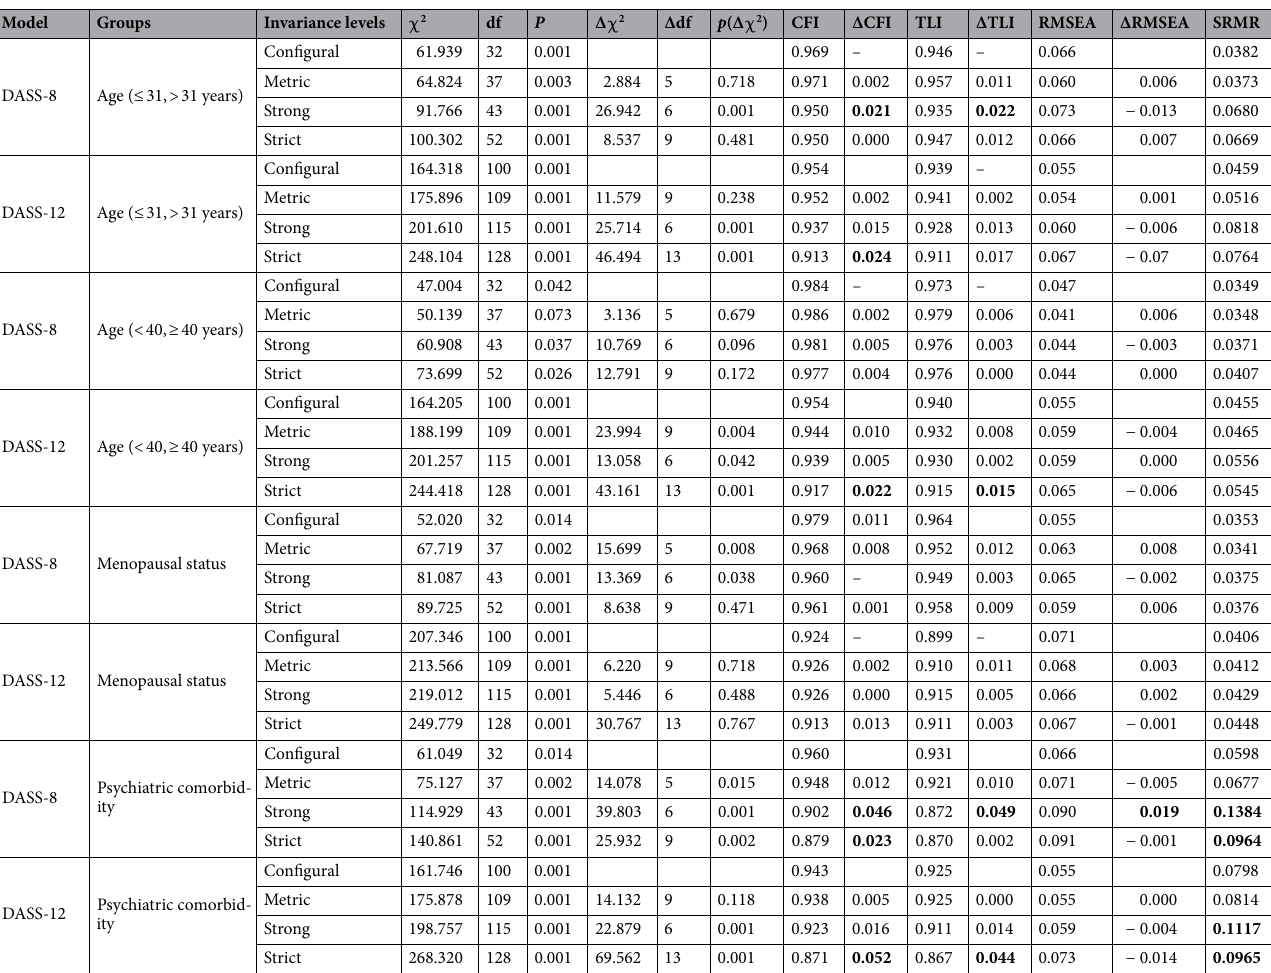
Table 3. Invariance of the three-factor structures of the Depression Anxiety Stress Scale 8 (DASS-8) and DASS-12 across groups of age, menopausal status, and psychiatric comorbidity. χ 2 , chi-square; df, degrees of freedom; CFI, comparative fit index; TLI, Tucker–Lewis index; RMSEA, root mean square error of approximation; CI, confidence interval; SRMR, standardized root mean residual. Significant values are given in